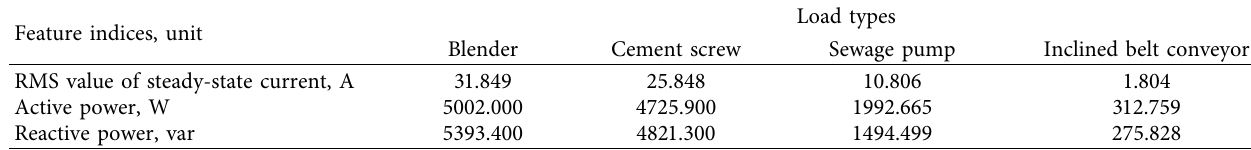
Figure 4: Current waveforms before and after data preprocessing for “sewage pump on” event. Table 5: Load steady-state feature matrix table.